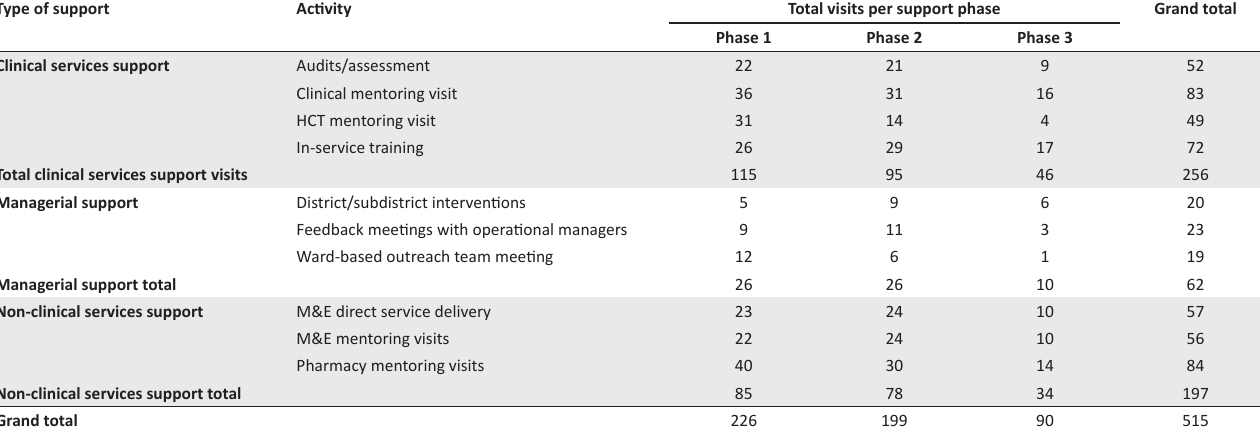
TABLE 4: Technical assistance support activities and number of visits. Type of support